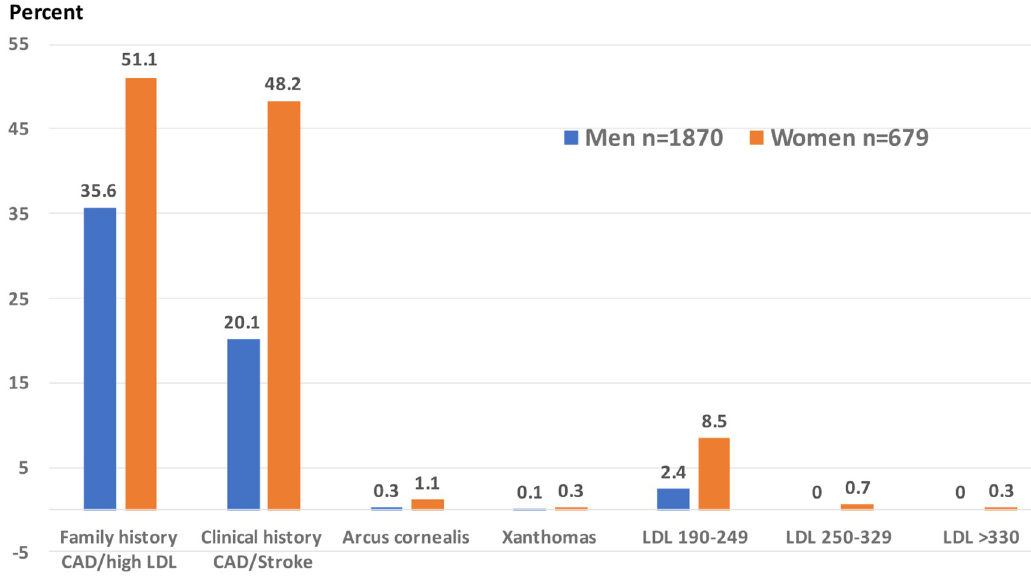
Fig 1. Components of Dutch Lipid Clinic Network FH diagnostic criteria in men and women in the study cohort.